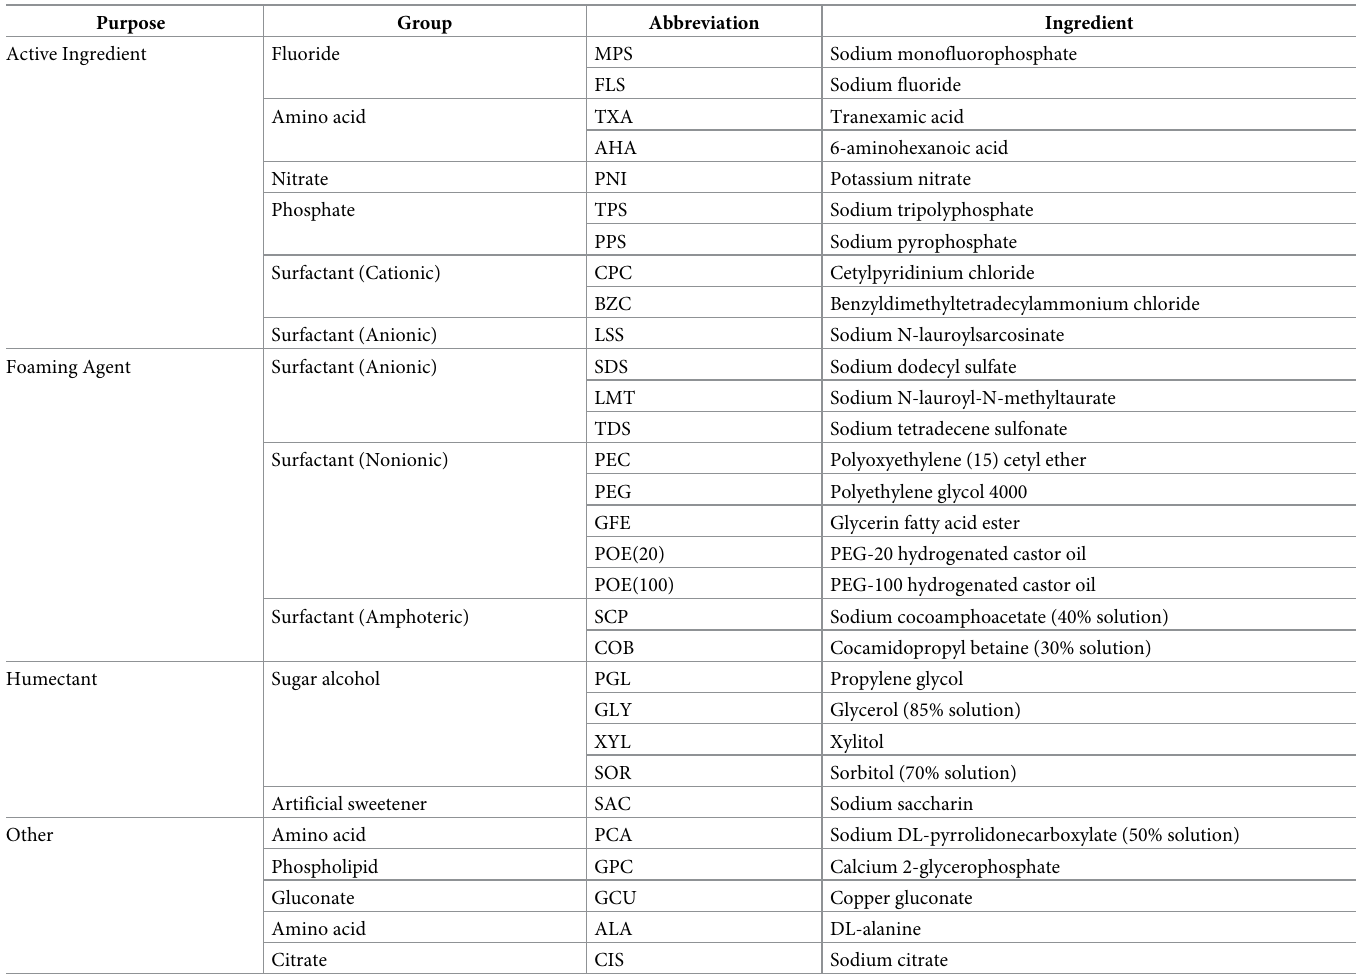
Table 1. List of test ingredients used for the in vitro screening.